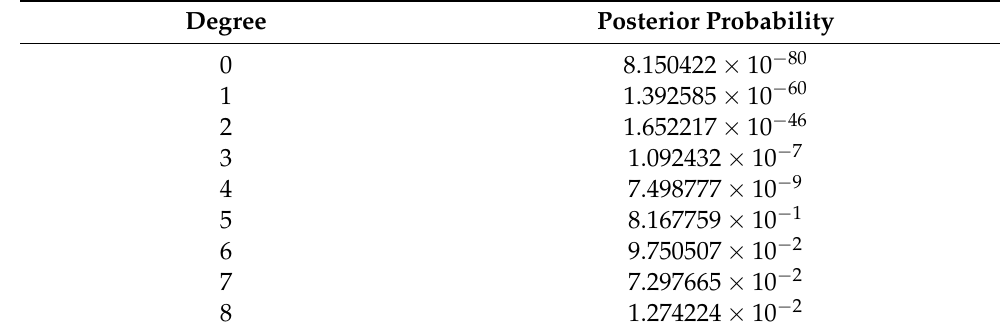
Table 2. Study of infected: Posterior probabilities of the polynomial regression model of degree less than or equal to 8 for the multi-sigmoidal Gompertz model.